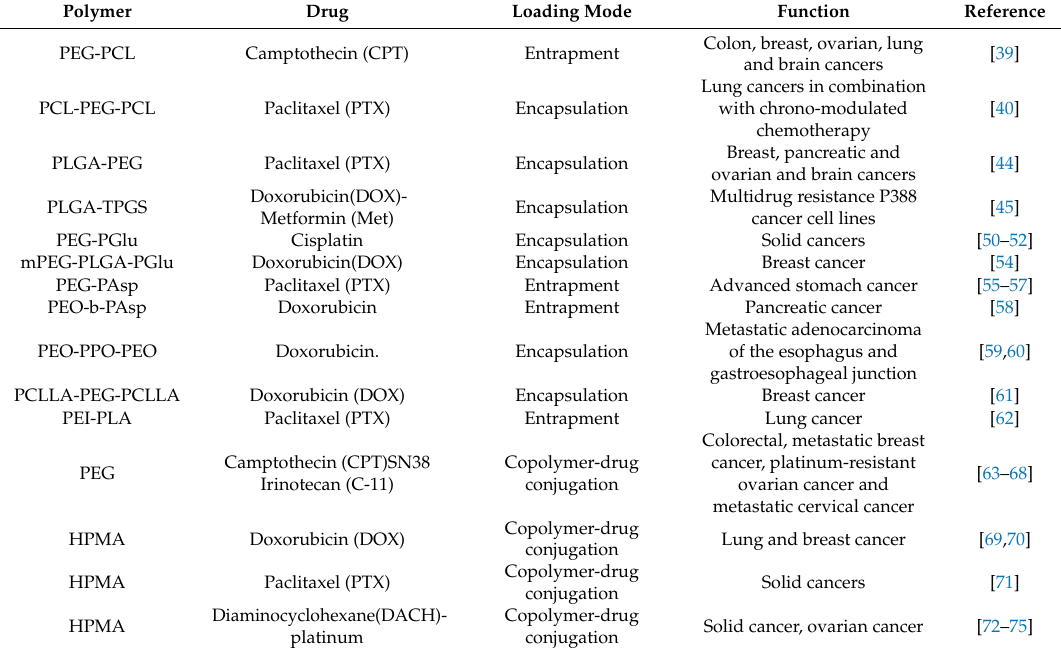
Table 1. Polymeric-anticancer drug nanoparticles (NPs), their loading mode and function. Polymer